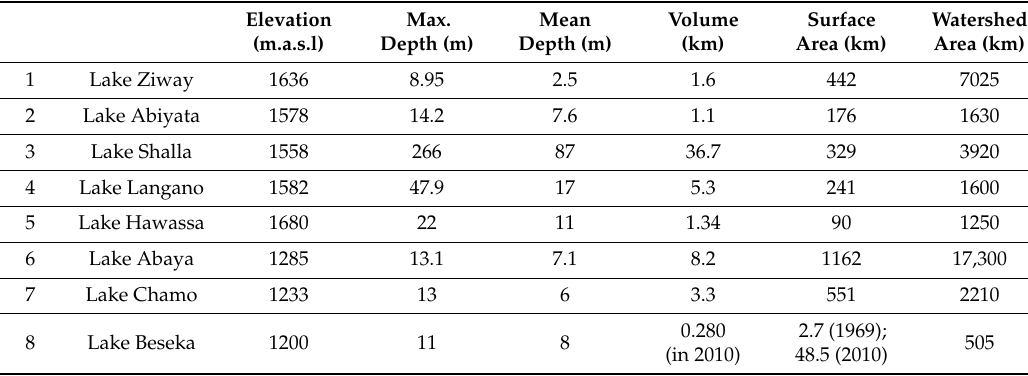
Table 1. Morphological characteristics of Rift Valley lakes.